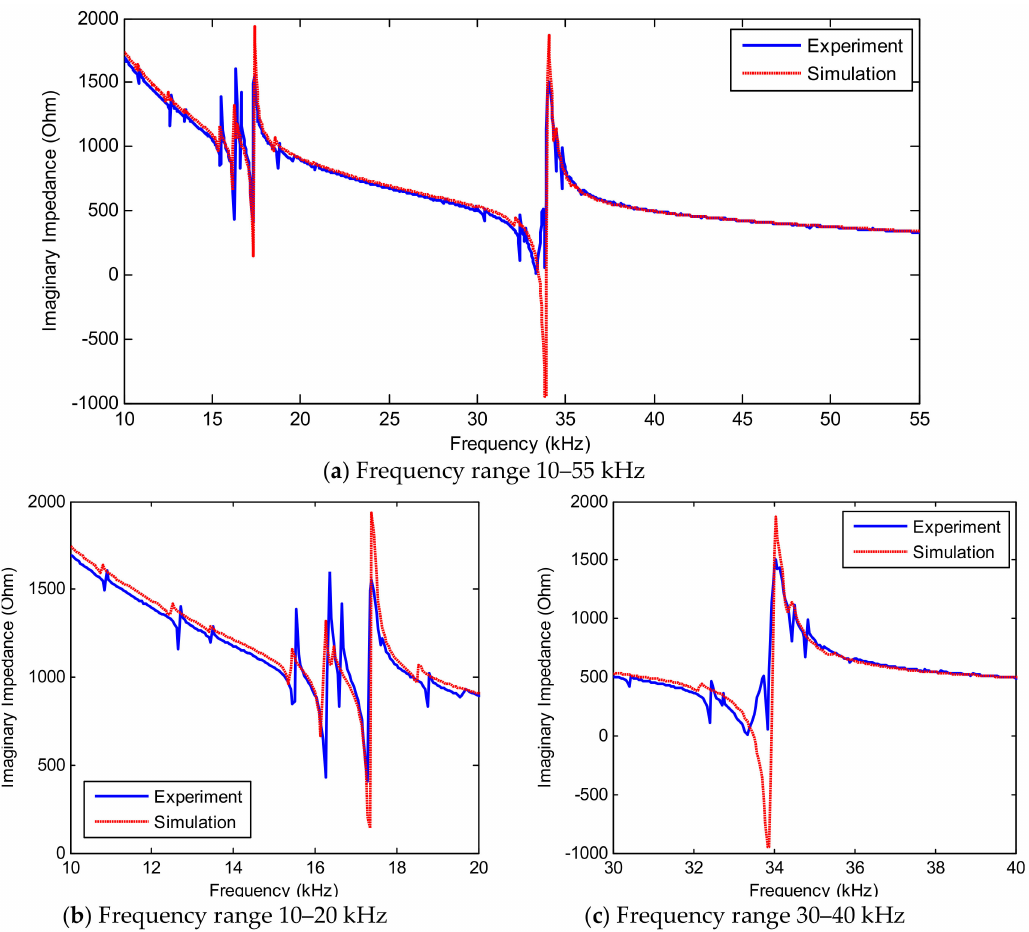
Figure 17. Imaginary impedance signatures of PZT interface under intact case of connection splice plate: simulation versus experiment.